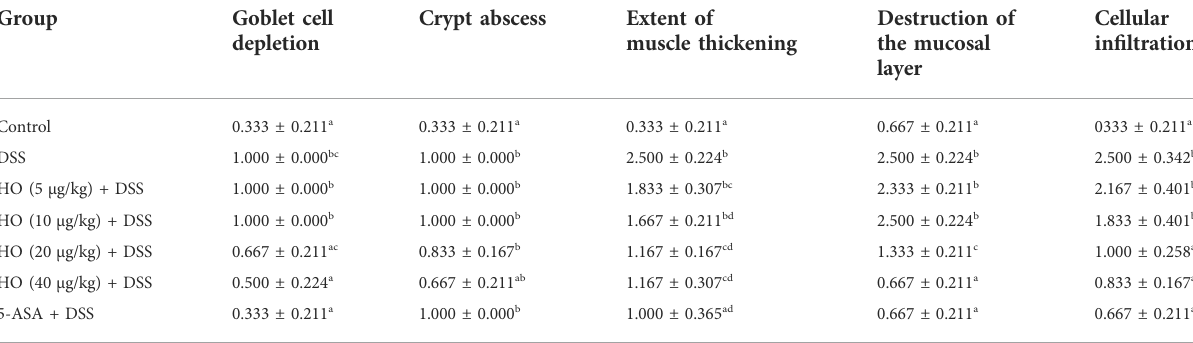
TABLE 2 Microscopic colonic damage score in each group mice.